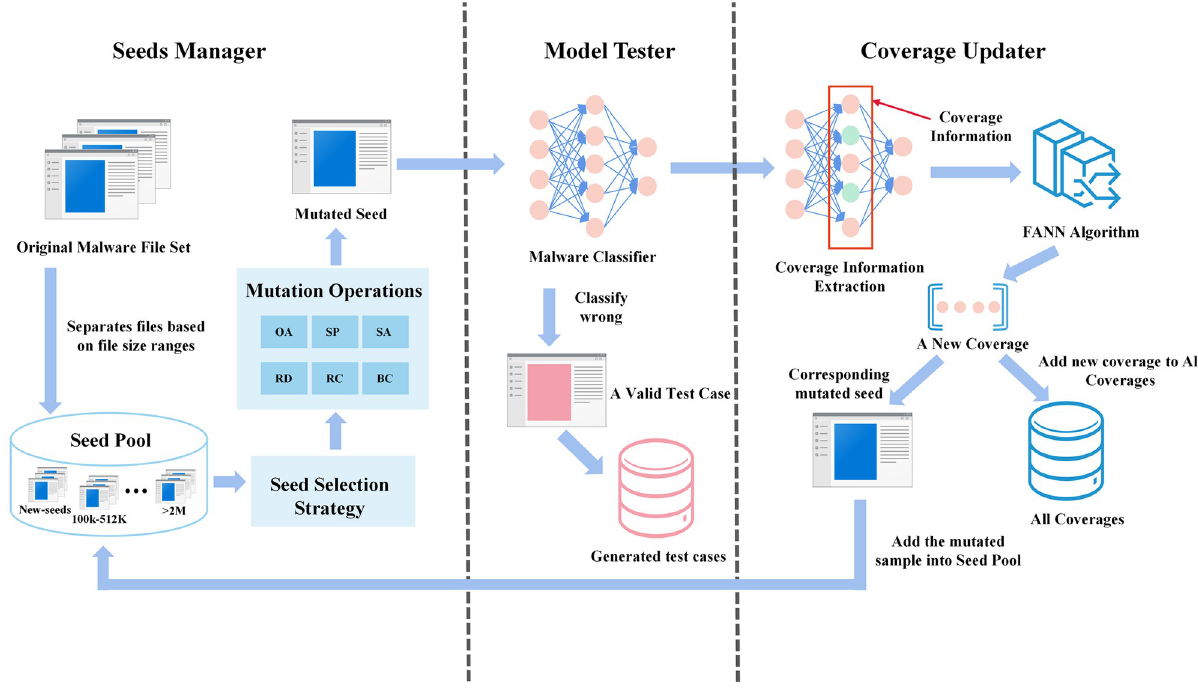
Fig 1. The overall architecture of